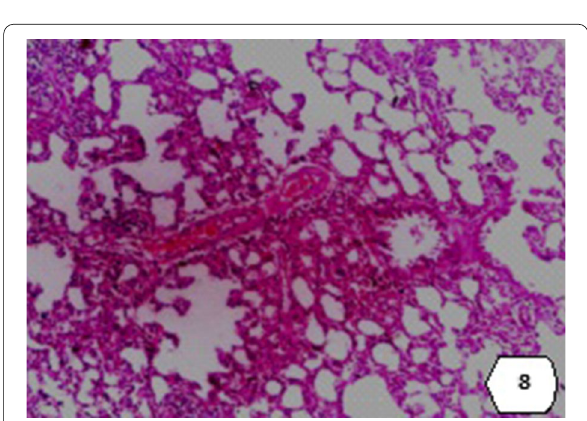
Fig. 8 Lung tissue image of normal control rats showing normal lung architecture (hematoxylin and eosin